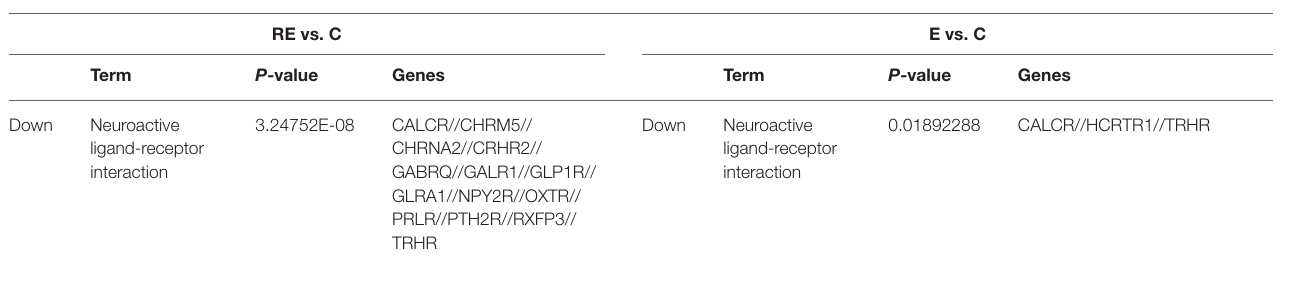
TABLE 1 | Common element in “RE vs. C” and “E vs.